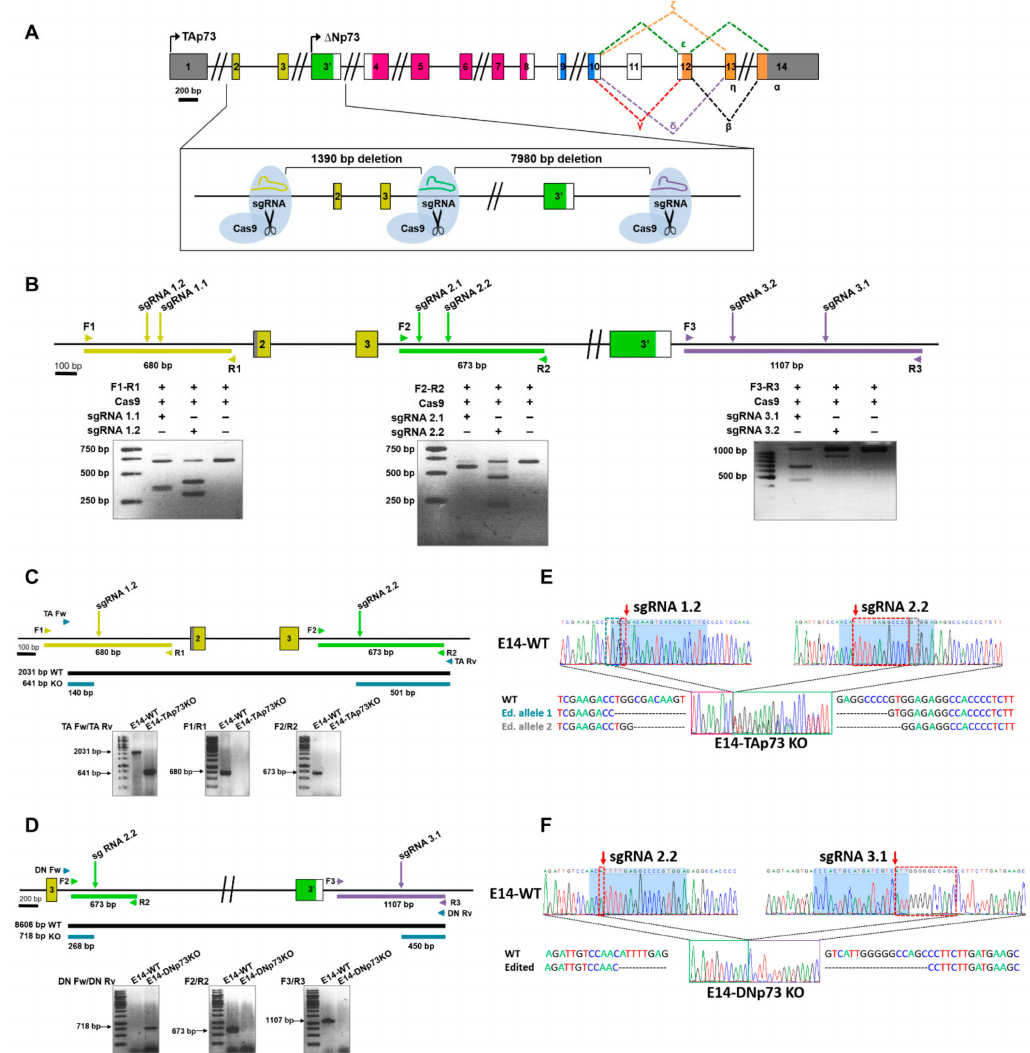
Figure 1. Generation of TA- and DN-p73-specific knockout mESC by CRISPR/Cas9 gene editing. ( A ) Diagram of the followed strategy. ( B ) In vitro assessment of the CRISPR/Cas9-mediated cleavage. Target regions were amplified by PCR from E14TG2 α genomic DNA and incubated with the Cas9 protein and the corresponding sgRNA. Cleavage locations are indicated by arrows. ( C , D ). The scheme indicates the expected PCR fragments (Primers Fw/Rv) to confirm correct gene editing of the E14-TA- ( C ) and E14-DN- ( D ) p73KO clones. Amplification across the boundaries of the sgRNA binding regions (Primers F1/R1, F2/R2 and F3/R3) showed the expected amplicon size for E14-WT genomic DNA, while no products were detected for the edited clones. ( E , F ) Sequencing electropherograms from E14-WT cells and the selected clones (E14-TA and E14-DN-p73KO, respectively). The E14-TAp73KO clone shows a 1390 bp deletion plus small different indels between both alleles in the boundaries of the deletion ( E ), while the E14-DNp73KO clone has a 7890 bp deletion (including a 14 bp indel, red dotted-squares), homozygous for both alleles ( F ). Blue-shadowed sequence corresponds to sgRNA target